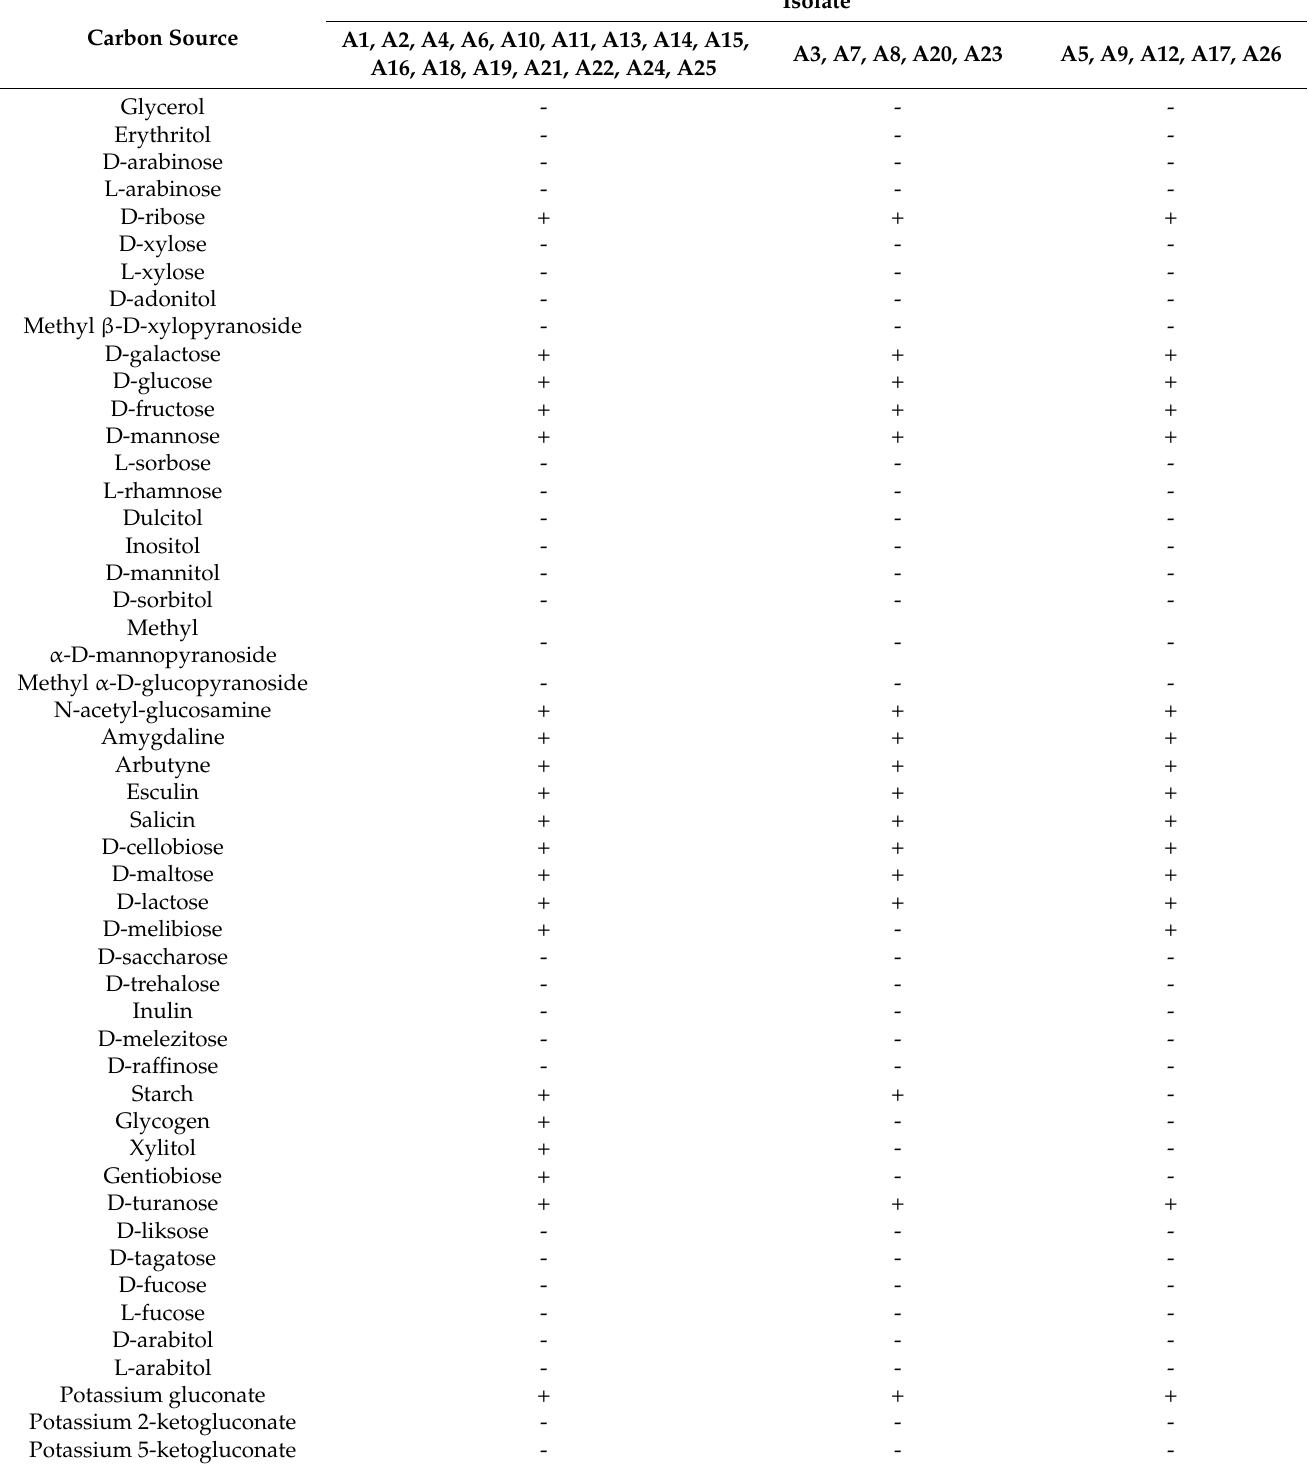
Table 2. Results of carbohydrate fermentation by the L. lactis isolates assessed with the API 50CH